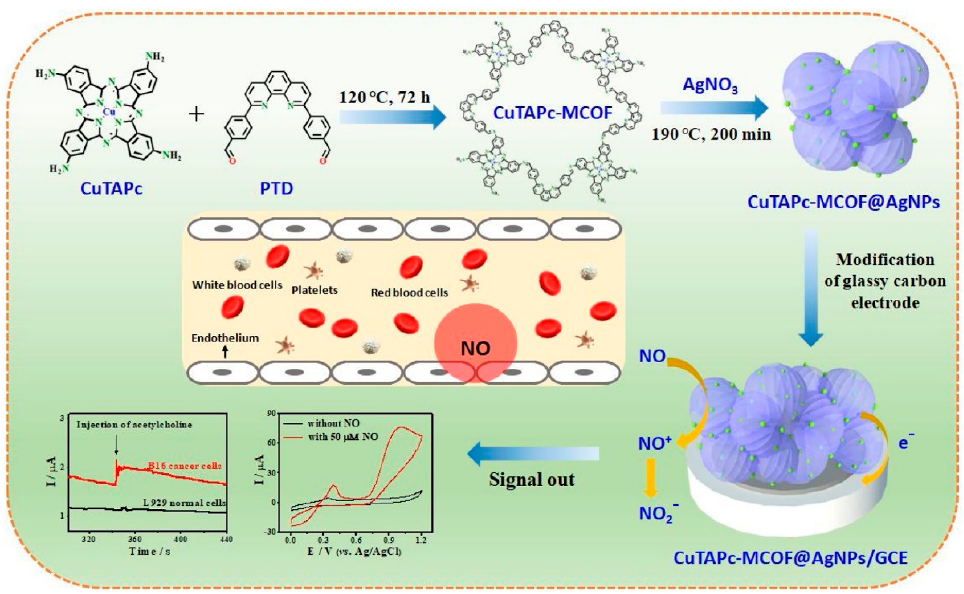
Figure 13. Schematic illustration of the synthesis of CuTAPc-MCOF@AgNPs nanohybrid for electrochemical detection of NO released from living cells. Reprinted with permission from [54]. Copyright 2021 Elsevier.